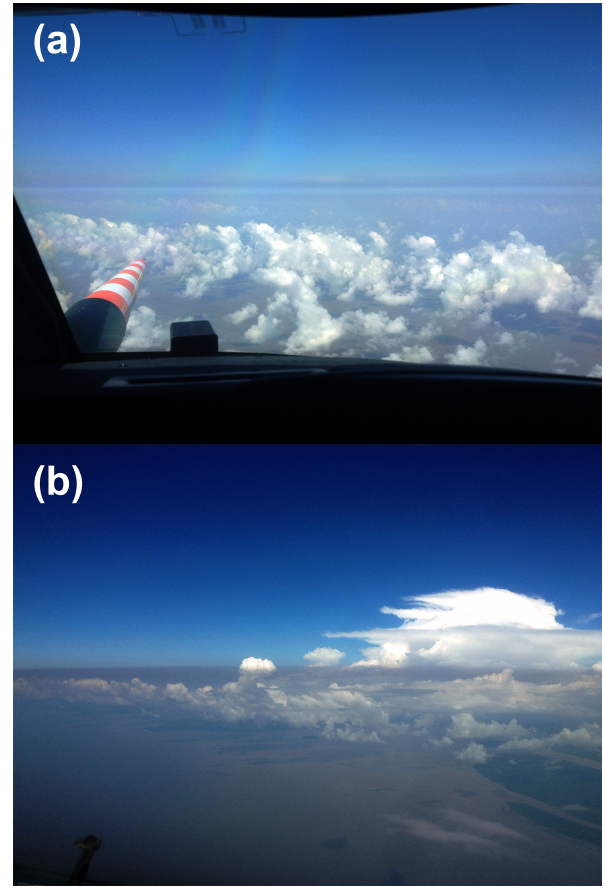
Figure 2. View from the HALO cockpit during flight AC19 on 30 September 2014, showing (a) the layering of the troposphere with clearly visible pollution layers as well as a clean layer in be- tween at an offshore location (17:09UTC) and (b) the brownish pollution layer arriving at the Brazilian coastline